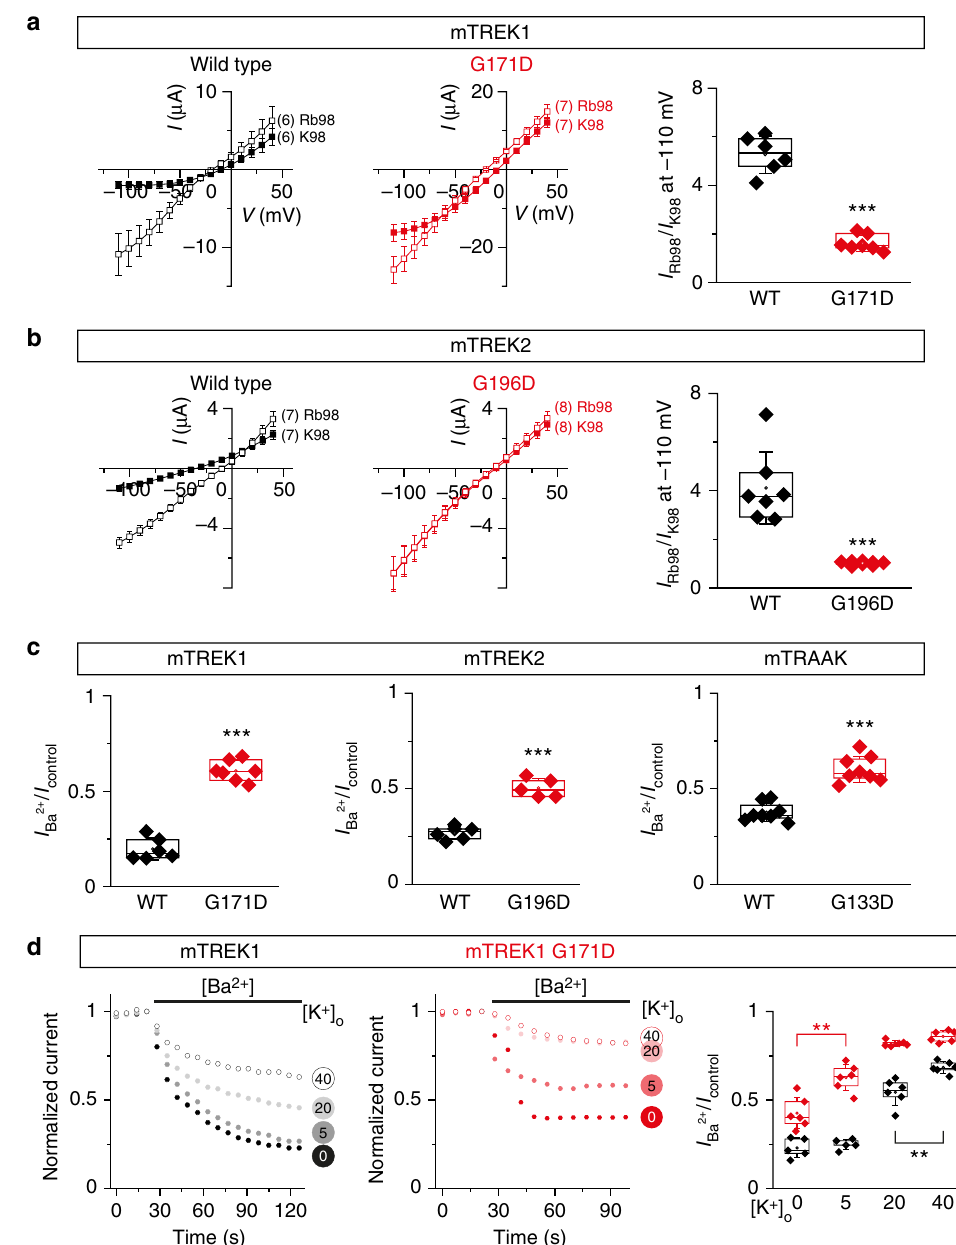
Fig. 3 TM2.6 mutations promote gating of mechano-gated K2P channels. a , b TM2.6 mutation affects TREK1 and TREK2 current increase induced by substituting potassium with rubidium. Current – voltage relationships of mTREK1 and mTREK2 channels; wild-type (black) and TM2.6 mutant (red) at 98 mM extracellular potassium ( fi lled squares) and 98 mM extracellular rubidium (open squares). Each data point represents the mean ± standard error of mean, numbers in parentheses represent the number of oocytes tested for each condition. Rightmost panels: mean relative current increases were 5.3 ± 0.3 and 1.6 ± 0.1 for wild-type and mutant mTREK1, respectively, and 4.1 ± 0.6 and 1.01 ± 0.02 for wild-type and mutant mTREK2, respectively. Currents were recorded 24 h after injection of cRNA at 1 ng/oocyte. c Magnitude of Ba 2 + inhibition is reduced in TM2.6 mutants of mechano-gated K2P channels. Ratios between currents under barium perfusion and currents under control perfusion at 0 mV, were signi fi cantly different for wild-type (black) and mutant channels (red). Mean ratios increased from 0.19 ± 0.02 (mTREK1) to 0.6 ± 0.02 (mTREK1 G171D), from 0.26 ± 0.01 (mTREK2) to 0.5 ± 0.01 (mTREK2 G196D), and from 0.37 ± 0.01 (mTRAAK) to 0.6 ± 0.02 (mTRAAK G133D). Currents were recorded 24 h after injection of cRNA at the following concentrations (in ng/oocyte): mTREK1 wild-type, 5; mTREK1 G171D, 1; mTREK2 wild-type, 3; mTREK2 G196D, 1; mTRAAK wild-type, 10; mTRAAK G133D, 0.1. d Inhibition of mTREK1 by 6 mM extracellular Ba 2 + in the presence of increasing concentrations of extracellular K + ([K + ] o ). Currents were recorded 24 h after injection of cRNA (mTREK1, black, 5 ng/oocyte; mTREK1 G171D, red, 1 ng/oocyte). Left and middle panels show normalized responses of one representative oocyte to barium challenge in the presence of [K + ] o (0, 5, 20, and 40 mM). Right panel: ratio between currents under barium perfusion and currents under control perfusion at 0 mV. Each data point represents one oocyte; center lines, medians; open circles, means; box limits, 25th and 75th percentiles; whiskers, standard deviation. Student ’ s unpaired t -test (except ( b ), Mann – Whitney), ** p < 0.01, *** p <